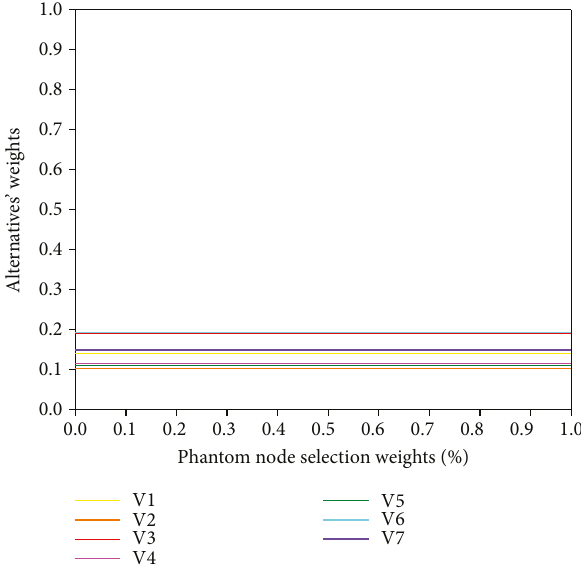
Figure 3: Scenario 1.